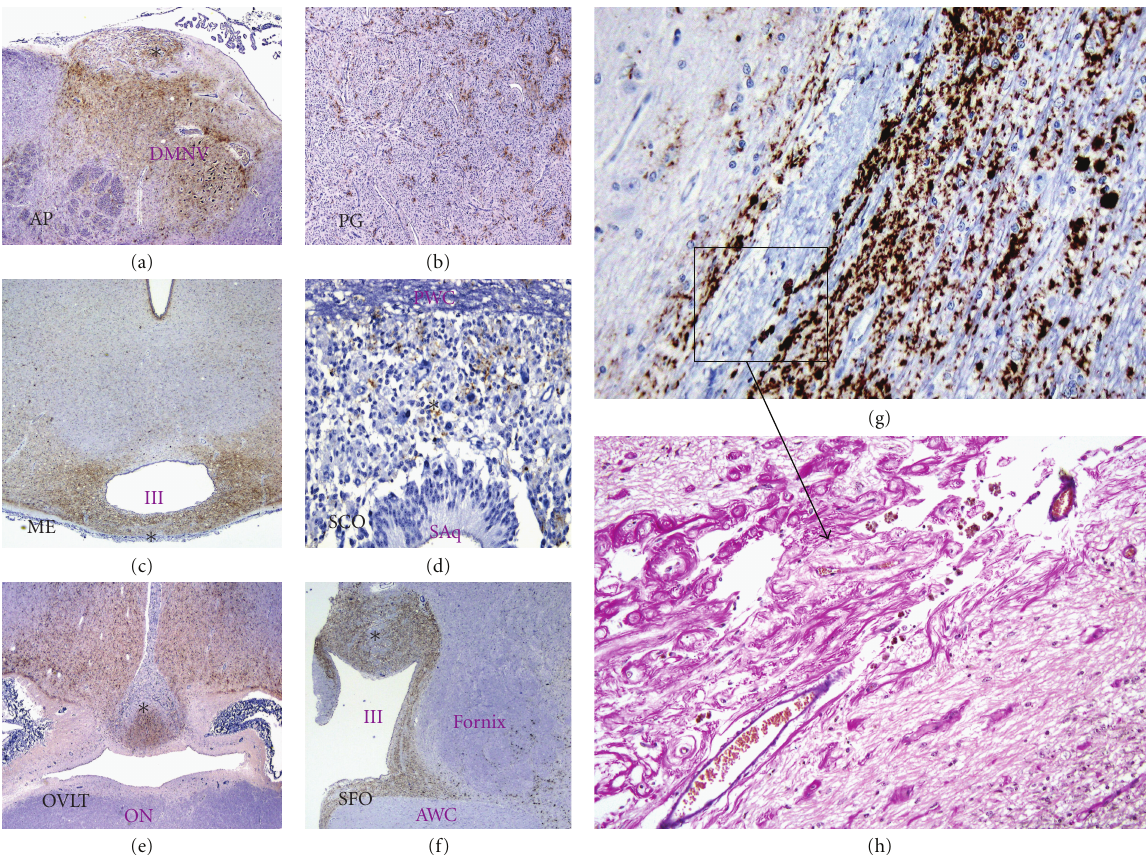
Figure 8: PrP d accumulation in CVOs and in the porencephalic lesion . Sheep CVOs highlighted with an asterix in pictures (a–f) of low magnification showed consistent PrP d deposition after intracerebral inoculation with BSE. Note that the porencephalic lesion which is surrounded by PrP d accumulations (g; x10) has abundant proliferation of newly formed vessels as revealed by a Van-Gieson staining (h; x20). CVOs: AP, area postrema; PG, pineal gland; ME, median eminence; SCO, subcommisural organ; OVLT, organum vasculosum of